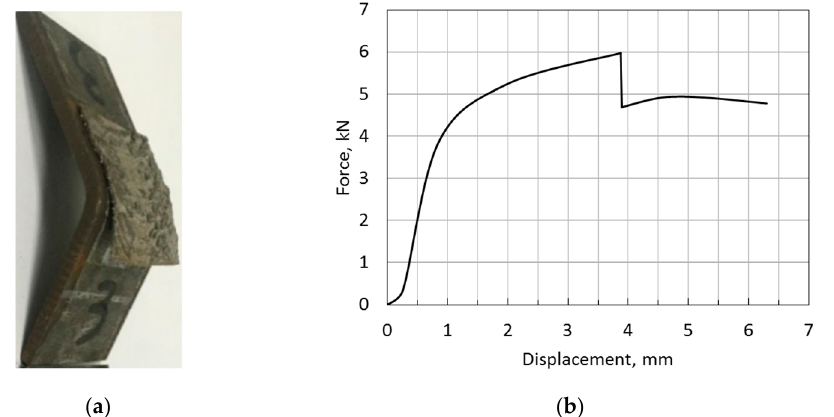
Figure 21. Bending test for sample 3: ( a ) sample; ( b ) force-displacement curve. Metals 2019 , 9 , x FOR PEER REVIEW